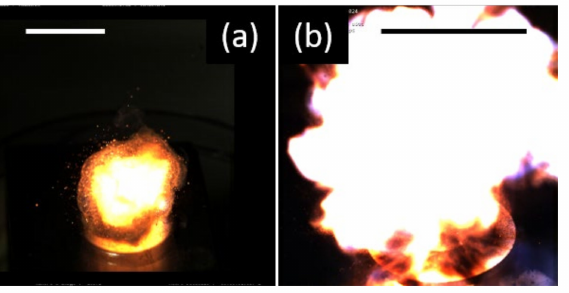
Figure 2. Combustion images of the ( a ) Al/ITO_ µ m and ( b ) Al/ITO_nm energetic composite materi- als ( φ = 1.2) recorded at 20 ms and 1 ms after the thermal impulse provided by the optical igniter. The white or black scale bar (on top on images) represents 20